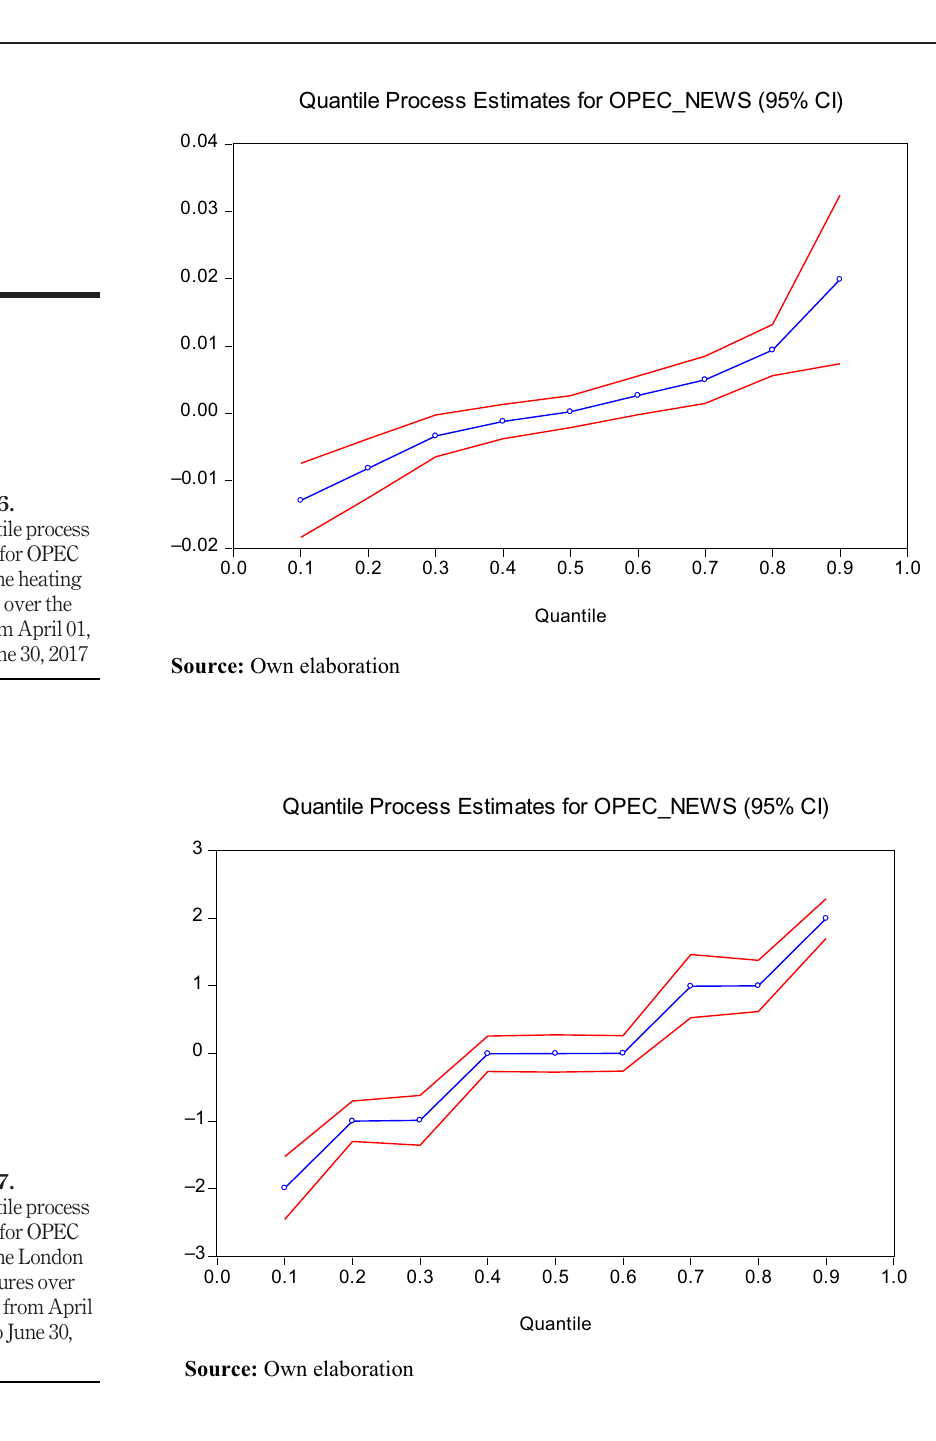
Figure 17. The quantile process estimates for OPEC news on the London gas oil futures over the period from April